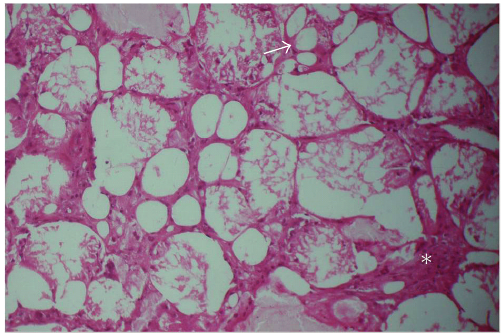
Figure 3: Pleomorphic lipocytes (arrows) encompassed in intersti- tial stroma and serosal lining (asterix) along with some steatonecro- sis (H&E